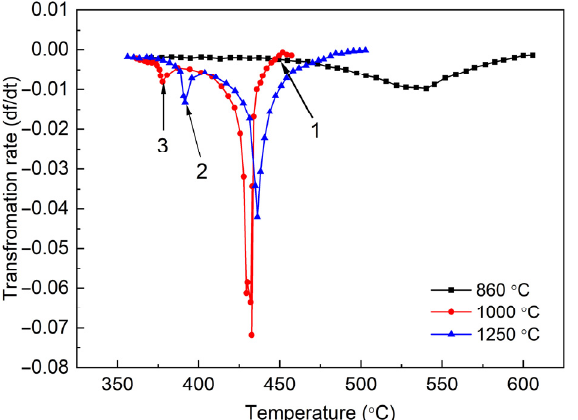
Figure 6. Phase transformation rate versus cooling temperature for the experimental steel at differ- ent austenitization temperatures. Arrow 1 indicates the transformation stasis at the beginning of transformation. Arrows 2 and 3 indicate the second peak in the transformation rate curves.